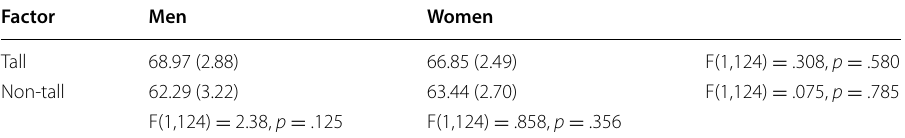
Table 1 Pairwise comparisons on respondents’ favorability in dependence on respondents’ gender or tallness